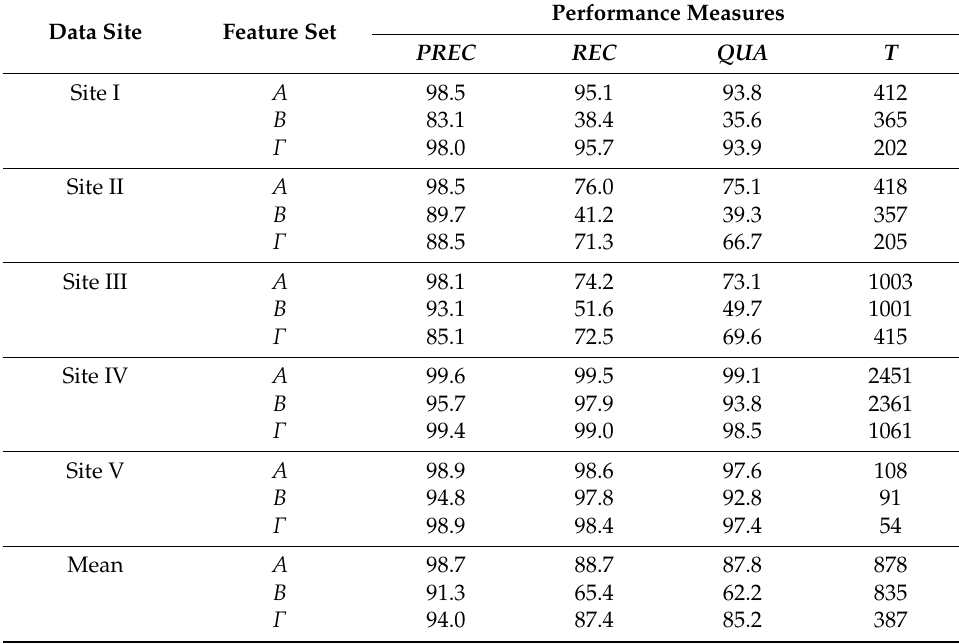
Table 5. Classification performance for three different feature sets ( PREC = precision rate in